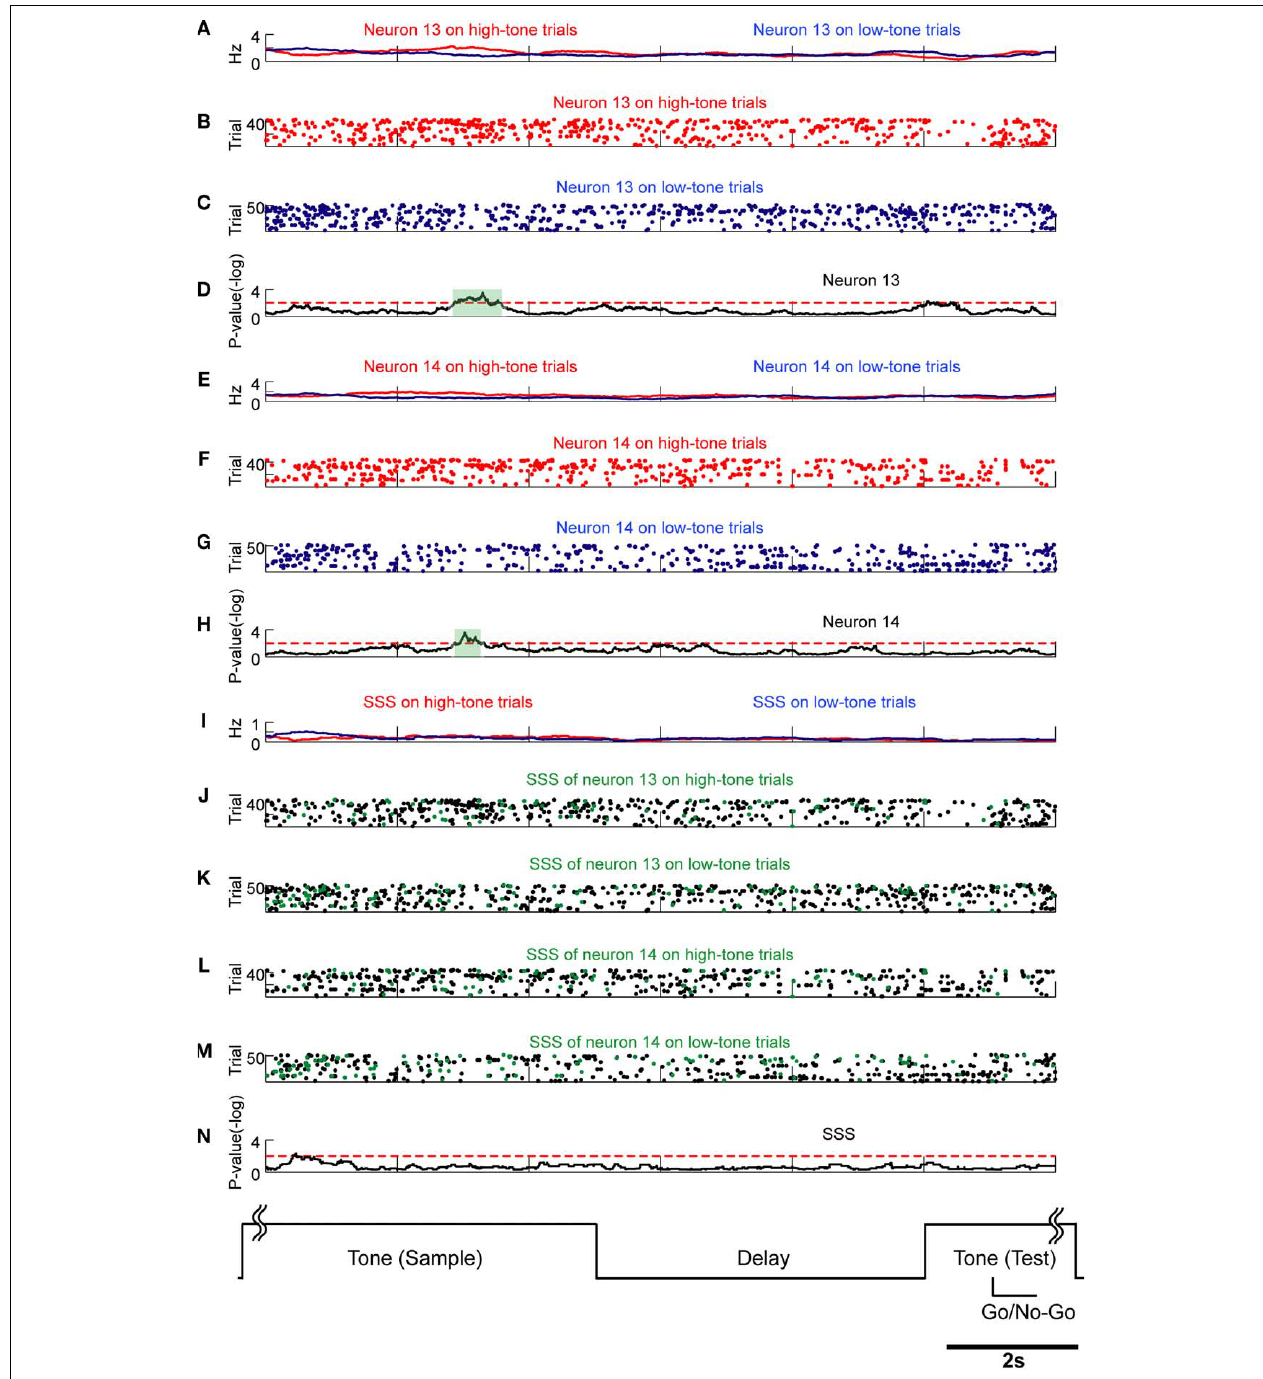
FIGURE 11 | Rate modulations related to stimulus inputs are not associated with SSSs. Comparison of SSSs and rate modulations between high tone (red) and low tone (blue) trials was selected in this example. Results of U -tests of 5 s of tone presentation in the preceding trial, 5 s of delay, and 2 s of tone presentation in the next trial are shown. (A) Firing rates of neuron 13 in high tone (red) and low tone (blue) trials. (B,C) Raster plots of spikes of neuron 13 in high tone (red) and low tone (blue) trials. (D) P -values of neuron 13 for a difference